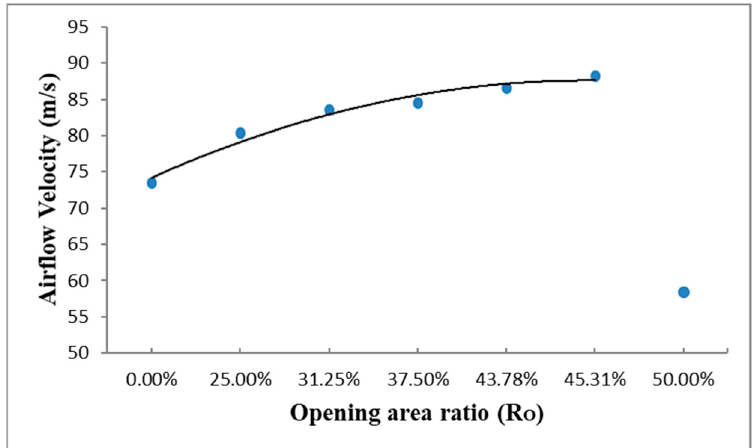
Figure 14. Airflow velocity corresponding to opening ratio of OWC gate.